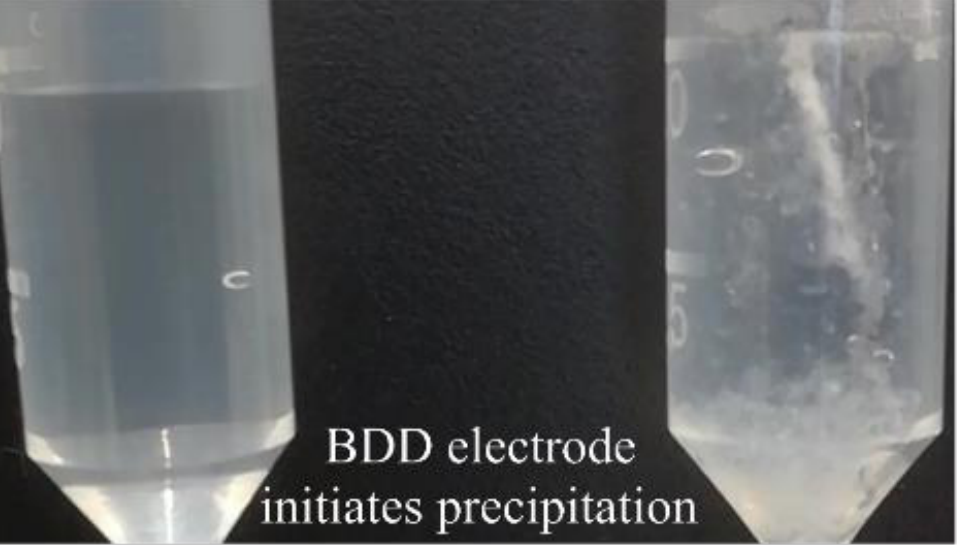
Figure 4. Comparison of CaP precursor solution before (left) and during (right) BDD electrode application. The left CaP precursor was stable through the whole time of the experiment, while precipitation of CaP started directly after current application.